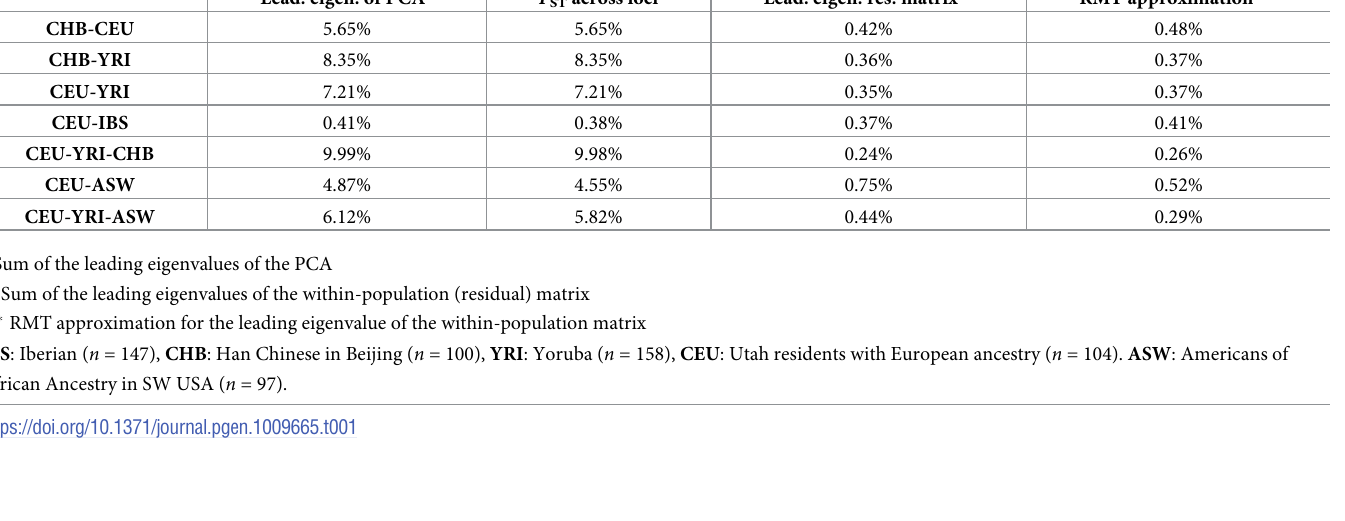
Table 1. F ST estimates for populations from The 1,000 Genomes Project. Lead. eigen. of PCA � F ST across loci Lead. eigen. res. matrix �� RMT approximation